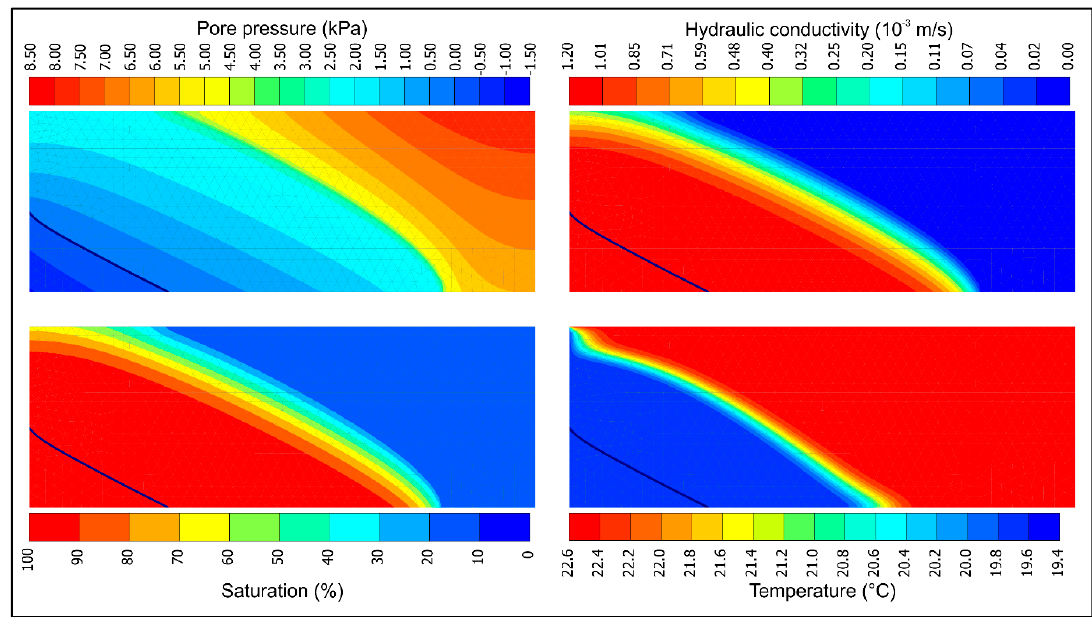
Figure 9. Schematic results from numerical modeling in PLAXIS 2D at running time 120 s. Note that compression (pore pressure) is negative in PLAXIS.